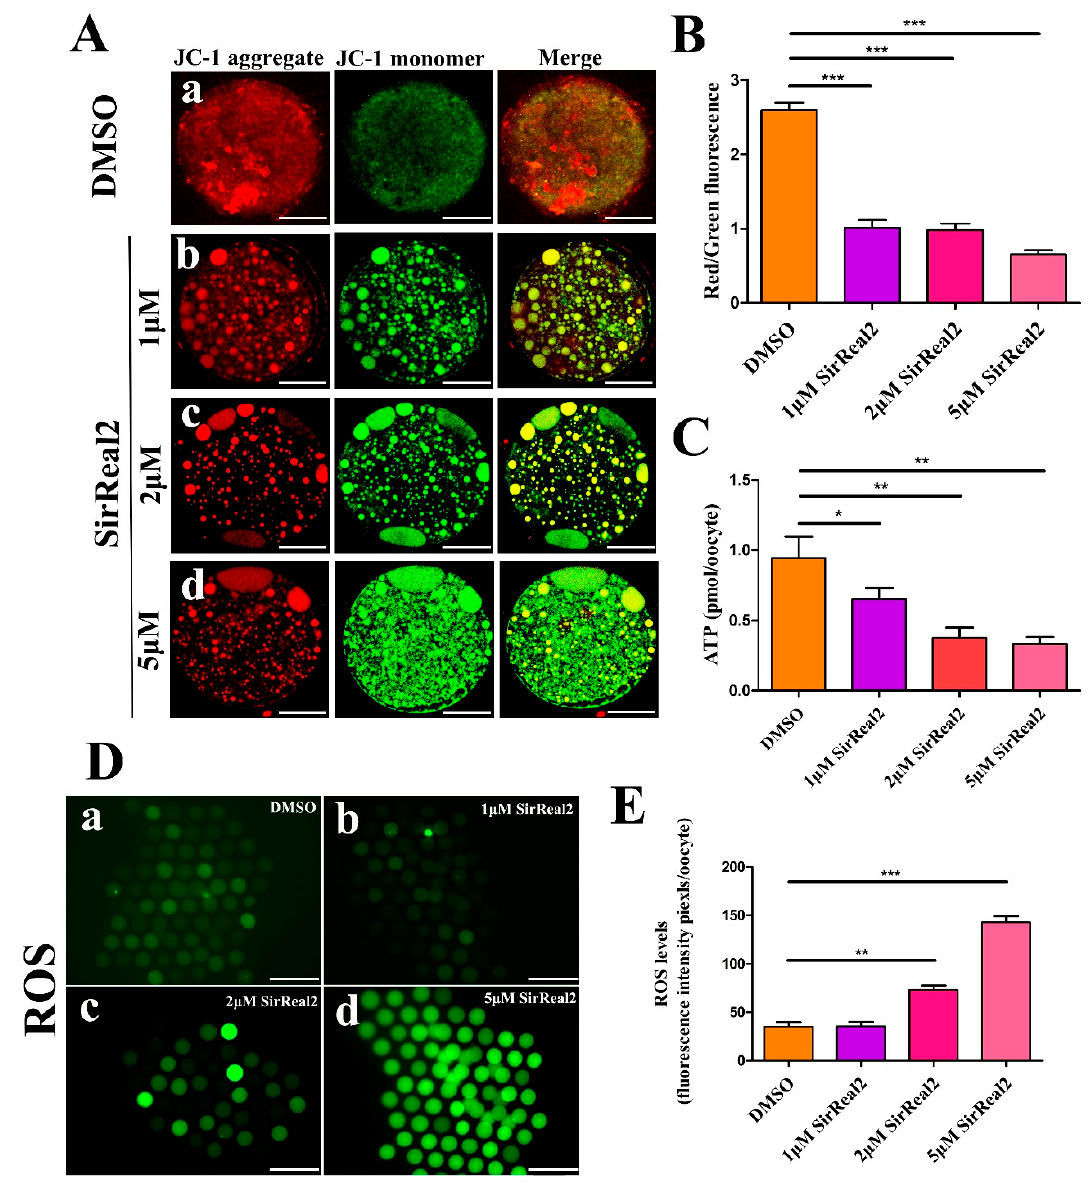
Figure 5. SIRT2 inhibition resulted in mitochondrial dysfunction. ( A ) Representative images of mitochondrial membrane potential in the control group (a) and SirReal2-exposed groups (b–d). JC-1 staining for visualizing the mitochondrial membrane potential of oocytes. The red fluorescence (JC-1 aggregates) indicates high membrane potential, whereas, the green fluorescence (JC-1 monomers) indicates low membrane potential. Scale bar: 30 µ m. ( B ) Fluorescence pixel ratio (red/green) in the control and SirReal2-exposed groups. ( C ) Histogram showing the ATP level in the control and SirReal2-exposed groups. ( D ) Representative images of dichloro-dihydro-fluorescein diacetate (DCFH–DA) fluorescence (green) in the control (a) and SirReal2-exposed groups (b–d). Scale bar: 200 µ m. ( E ) Quantification of reactive oxygen species (ROS) fluorescence intensity was analyzed with Image-Pro Plus software. Data are expressed as the mean percentage ± SEM from three independent experiments, in which at least 100 oocytes were analyzed. * p < 0.05, ** p < 0.01, *** p < 0.001, comparing the indicated groups.